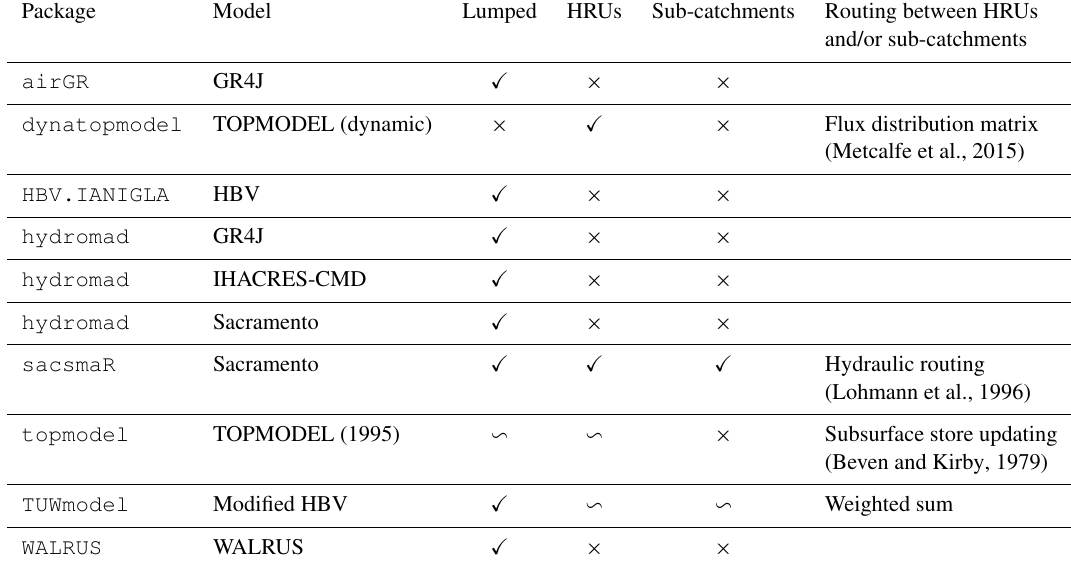
Table 3. Possible spatial configurations for each model. If a package allows a specific configuration ( (cid:88) ), then it means that the model is coded for this configuration in the related package, but it does not mean that the necessary preprocessing functions are provided. The tilde ( (cid:118) ) is for models following a spatial discretisation close to one of the